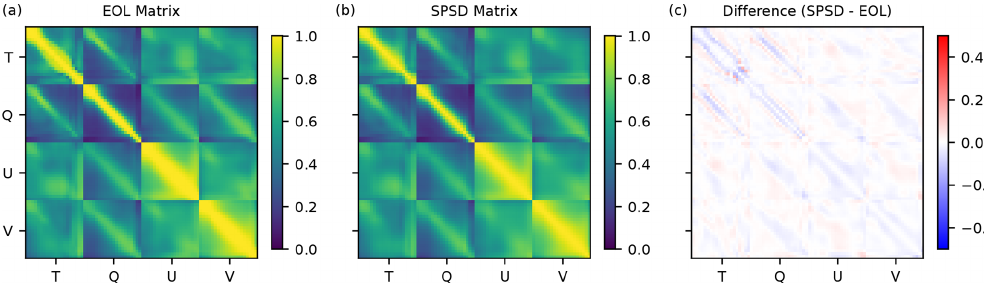
Figure 10. Examples of EOL-based localization matrices for a single vertical column: (a) matrix C constructed based on the SINGLE case, (b) the resulting nearest correlation matrix C following the NCM algorithm, and (c) changes due to enforcing positive